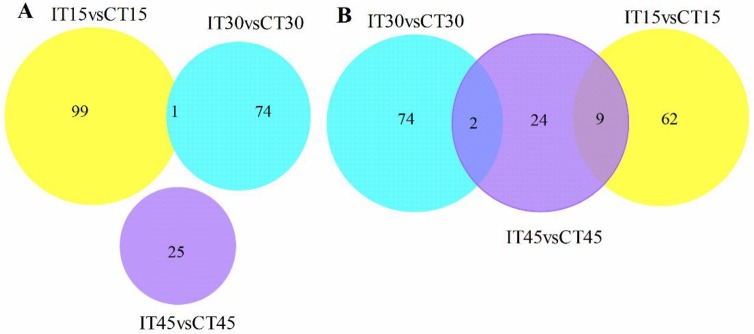
Venn diagram of differentially expressed gene sets across three distinct groups.(A) represents up-regulated genes (B) represents down-regulated genes.